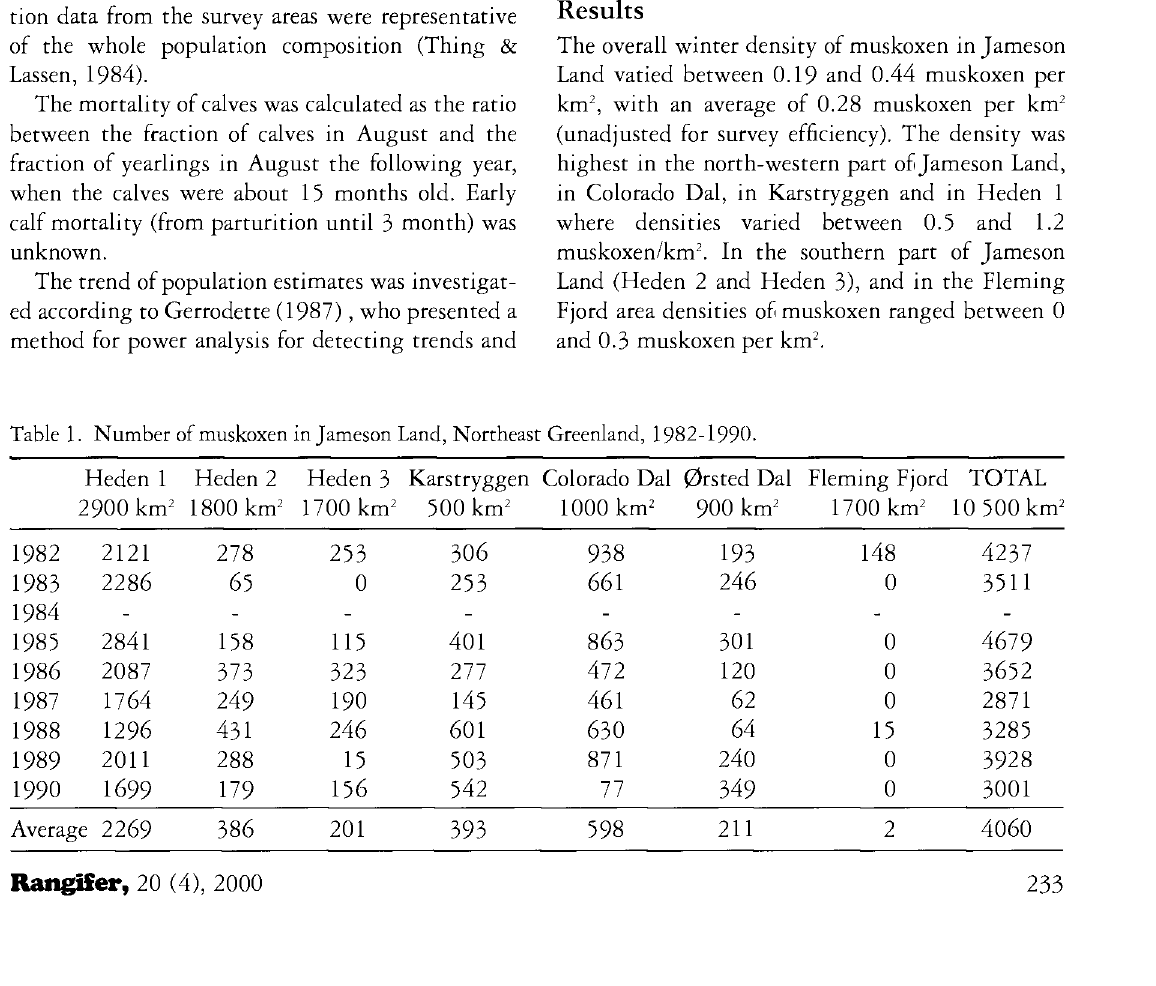
Table 1. Number of muskoxen in Jameson Land, Northeast Greenland, 1982-1990. Heden 1 Heden